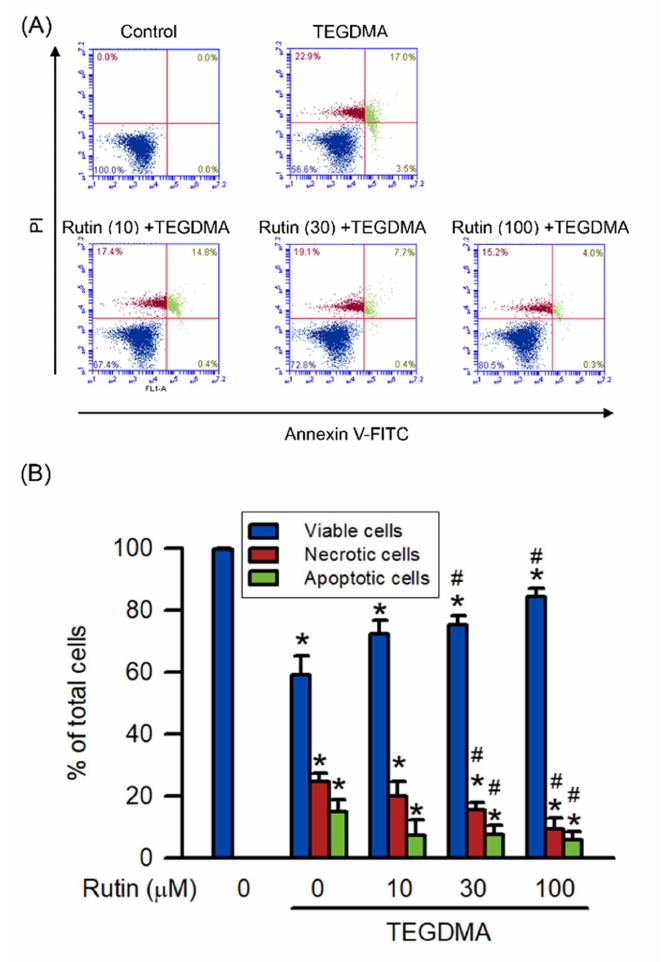
Figure 2. Effect of rutin on TEGDMA-induced necrosis and apoptosis expression in RAW264.7 macrophages. Apoptosis of RAW264.7 cells was measured by flow cytometry using Annexin V- FITC/PI apoptosis detection kit. ( A ) The dot-plots of flowcytometry from the annexin V-FITC/PI staining assay are shown. ( B ) Quantitative analysis of the percentage of viable cells (Annexin V-FITC negative and PI negative), necrotic cells (Annexin V-FITC negative and PI positive), and apoptotic cells (Annexin V-FITC positive) was presented. Values are expressed as mean ± S.D. of three times per group. * Represents significant difference between the indicated and control groups, p < 0.05. # Means significant difference between the indicated and TEGDMA groups, p <